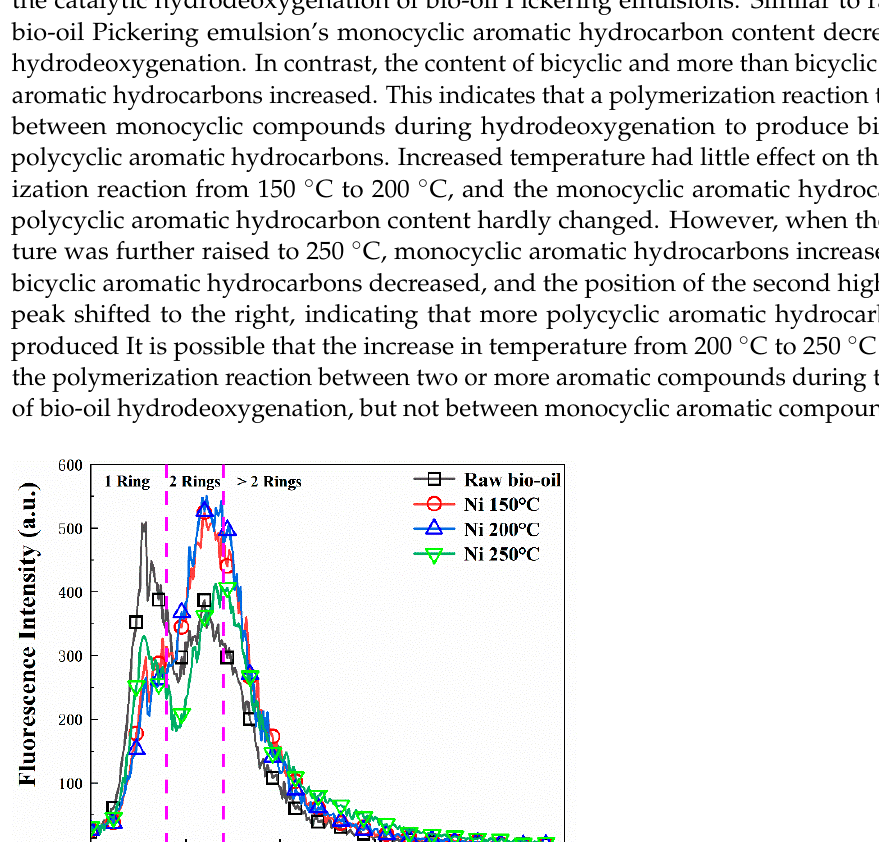
Figure 9. GC-MS results of raw bio-oil hydrodeoxygenation at 150 °C, 200 °C, and 250 °C.